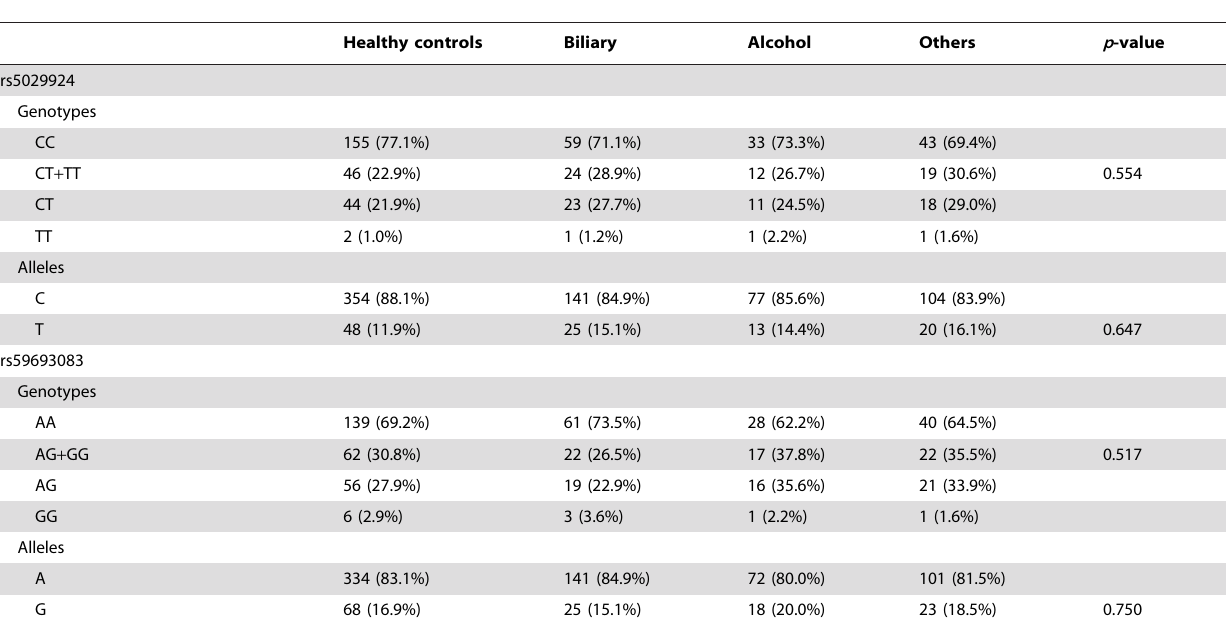
Table 3. Genotype and allele frequencies of TNFAIP3 promoter variants in different individuals with different AP etiologies.